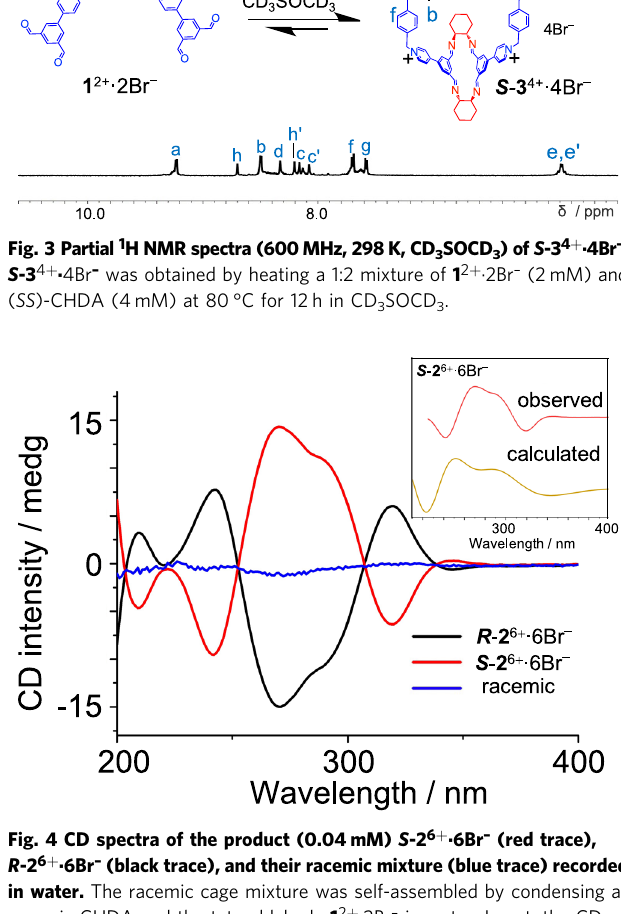
Fig. 2 1 H NMR spectroscopic characterization of S -2 6 + ·6Br – . A Structural